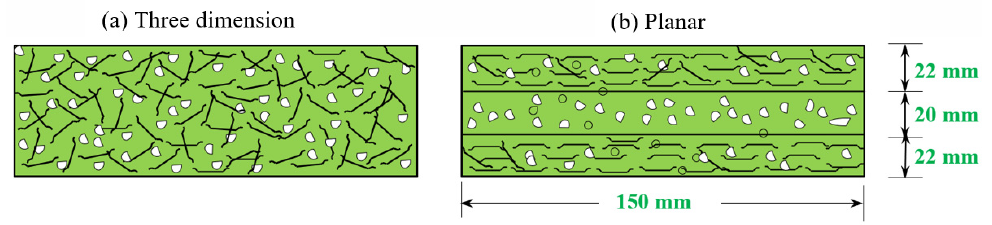
Figure 13. Orientation of fibres: ( a ) 3D; ( b ) planar.